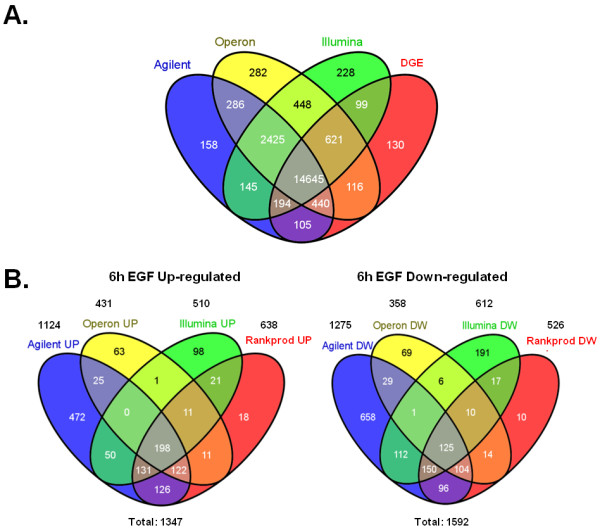
Microarray versus DGE analysis. (A) Overlap of unique and named genes shared among the 3 microarray platforms and genes detected by DGE. The pool of 14645 shared genes was used for further cross-platform analysis. The total numbers of genes for each platform and for all platforms combined are indicated. (B) Overlap of significantly regulated genes considering the 3 microarray platforms at 6 h after EGF treatment and the genes found regulated after assessing significance by grouping microarray and DGE data in a RankProd analysis. Left panels show up-regulated genes and right panels show down-regulated genes.